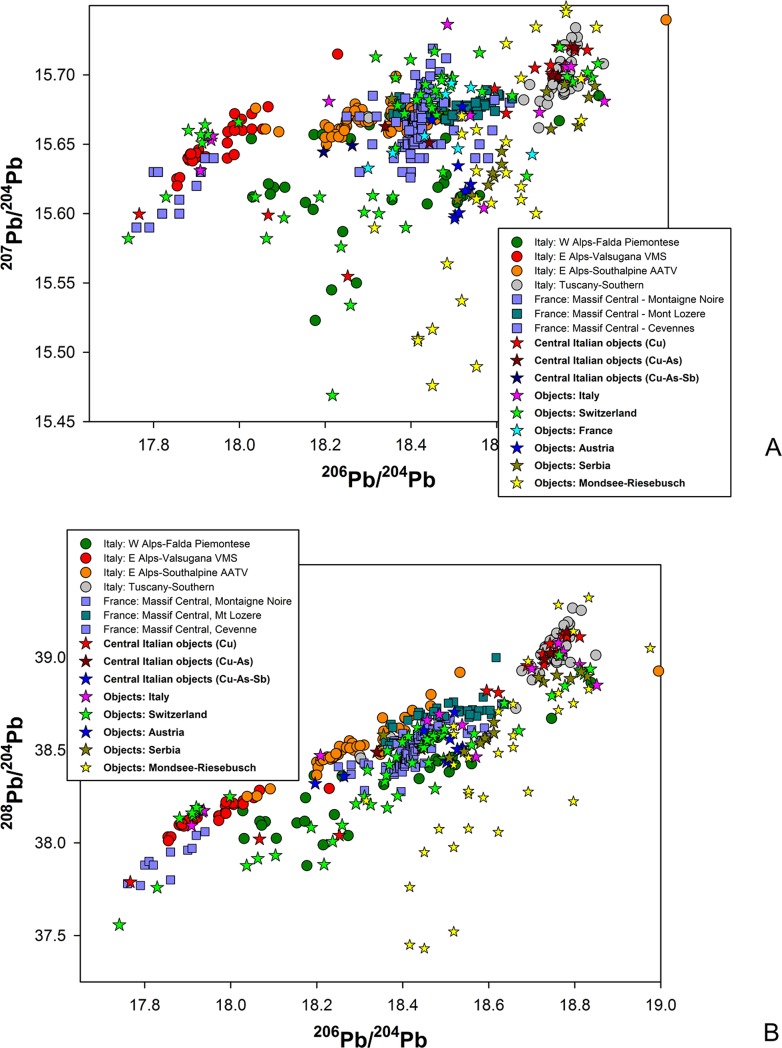
Comparison of the LI data of 4th
and 3rd
millennia BC objects from Italy, Switzerland, Austria and Serbia, with ore data; (a): 2D plot of 206Pb/204Pb vs 207Pb/204Pb LI data; (b) 2D plot of 206Pb/204Pb vs 208Pb/204Pb LI data.